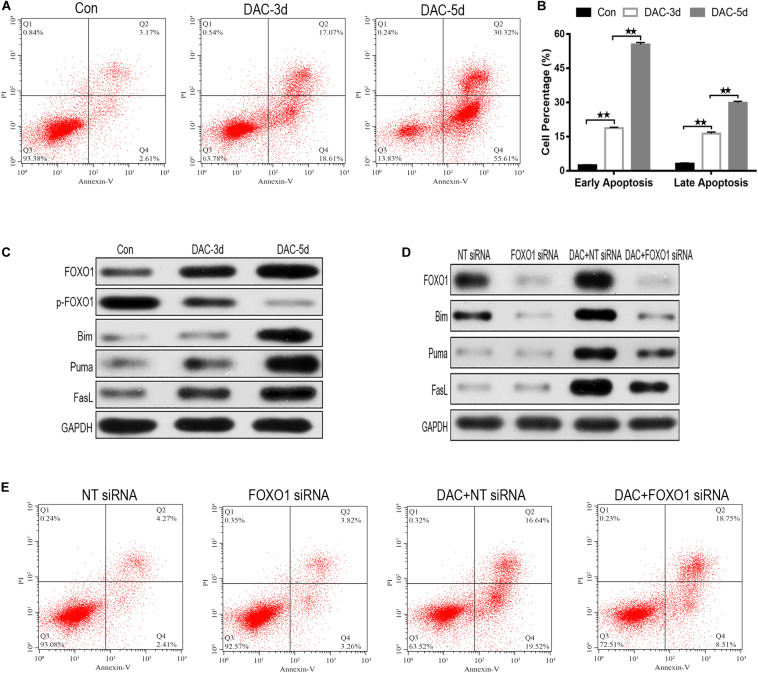
Decitabine (DAC) induces apoptosis in MDS-L cells. Annexin-V-FITC/PI assay showed that apoptosis occurred in MDS-L cells with DAC prolonged exposure time (A). FCM assay detected that DAC treatment could induce both early and late apoptosis in MDS-L cell (B). Western blot found that FOXO1, Bim, Puma, and FasL in MDS-L cells increased with p-FOXO1 protein decreasing after DAC treatment (C). FOXO1 silencing had no obviously influence on Puma and FasL, but decreased the expression of Bim that was observed following DAC treatment (D). MDS-L cell early apoptosis was partly inhibited after FOXO1 silencing and could not be significantly induced by subsequent DAC treatment (E). **Student’s t-test P < 0.01.